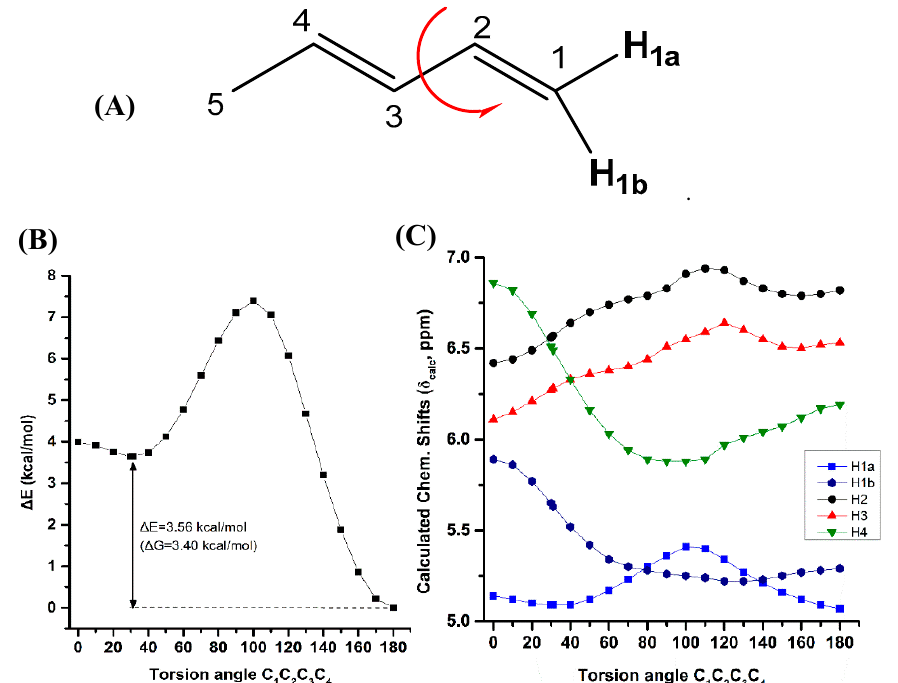
Figure 4. E ff ect of variation of the C 1 C 2 C 3 C 4 torsion angle of ( E )-1,3-pentadiene ( A ) on the electronic energy ∆ E (kcal · mol − 1 ) ( B ), and olefinic 1 H-NMR chemical shifts ( C ) with energy minimization at the B3LYP / 6-31 + G(d) level. The Gibbs energy di ff erence, ∆ G, of the two low energy conformers is also indicated.